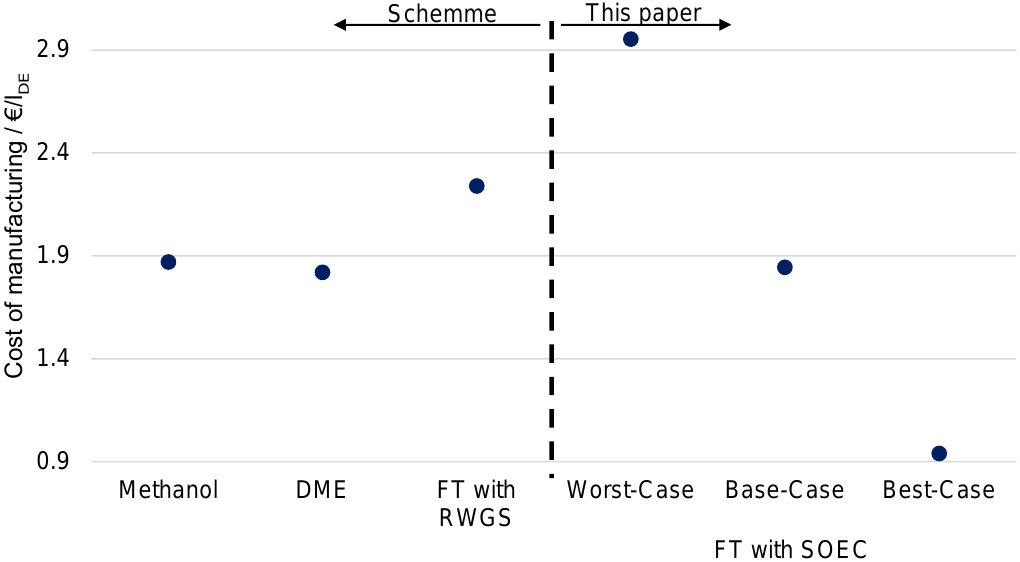
Figure 22. Comparison of the production costs of the developed fuel synthesis with those of alterna- tive power-to-liquid processes (costs of methanol, DME, and FT with the RWGS process according to Schemme [54] ).